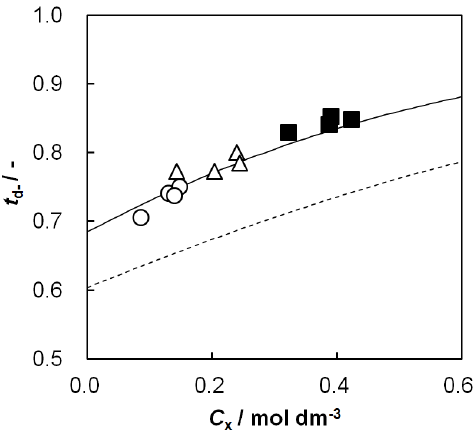
, of AEMs as a function of the effective Figure 8. Dynamic state transport number, t d − charge density, C . The definition of symbols in this figure is the same as in Figure 2. x The calculations: broken curve, β = 0.66; solid curve, β =